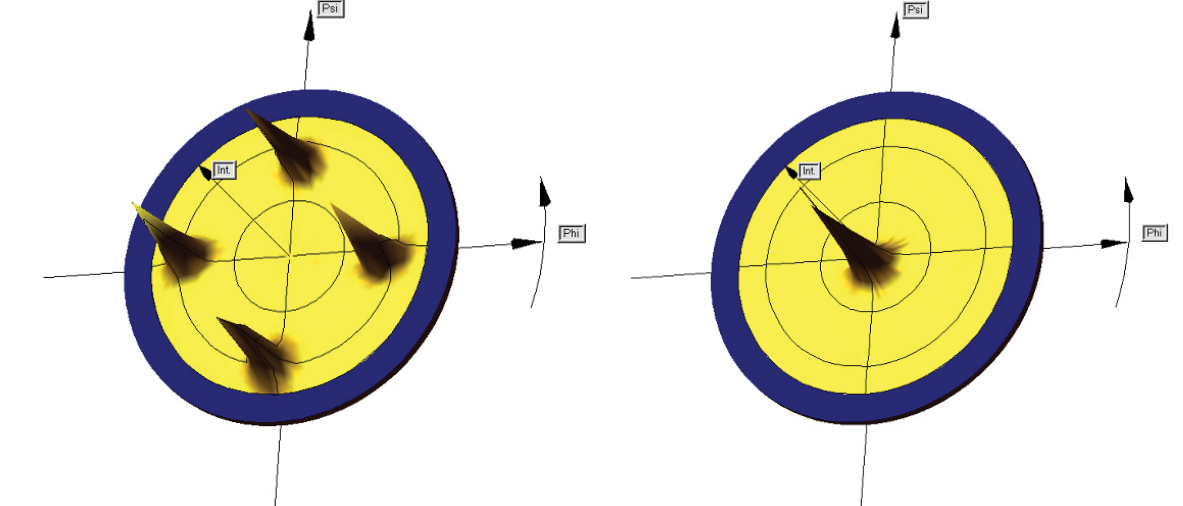
Figure 5. (111) and (200) pole figures of Cu substrate verified the sharp {001} <100> texture of the tape. (Thermal treatment: 900°C for 60 min). A quadratic presentation of the intensity was chosen to enhance possible low intensity Table 1. Tensile strengths and Young’s modulus values of cold rolled Cu tapes following EN 10002-1 B.